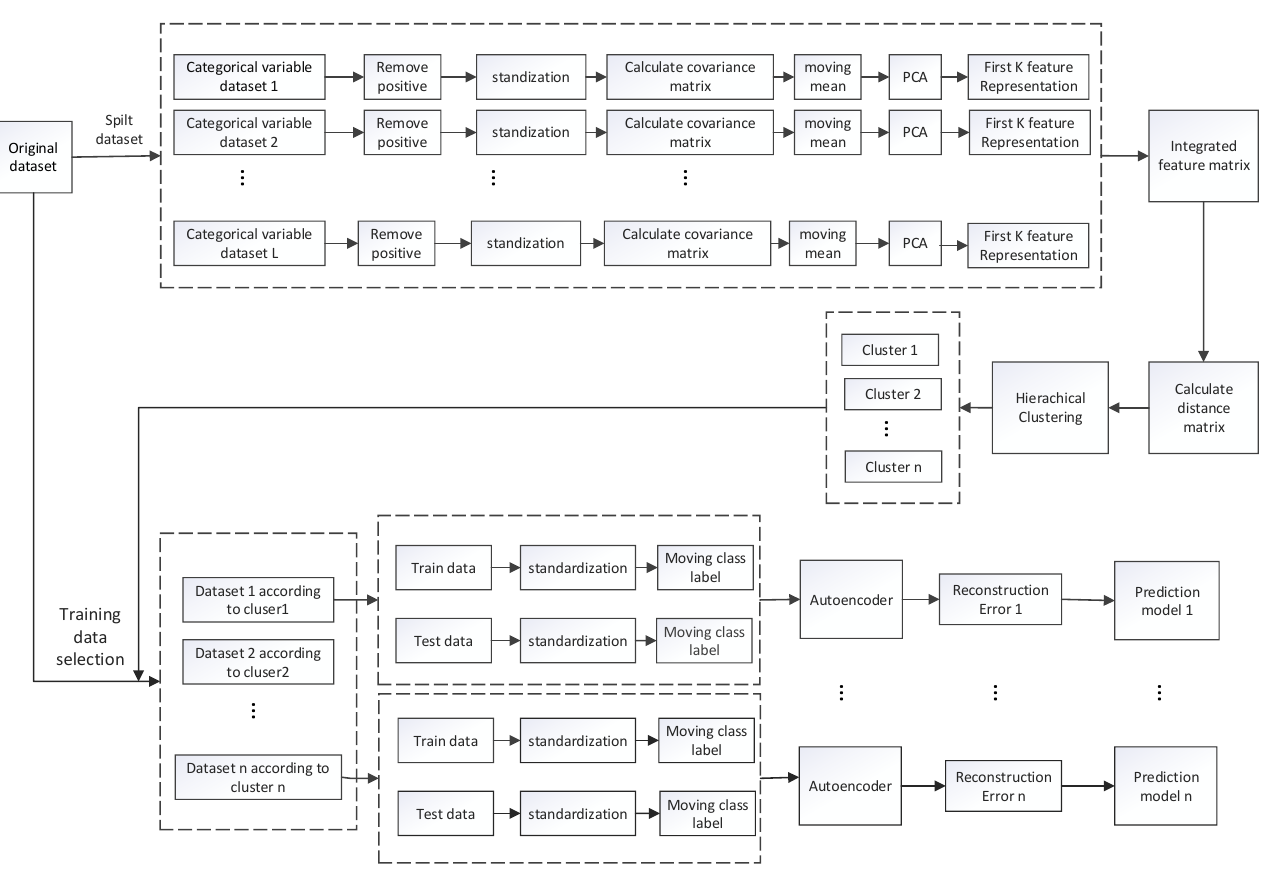
Figure 1. The flowchart of overall procedures.